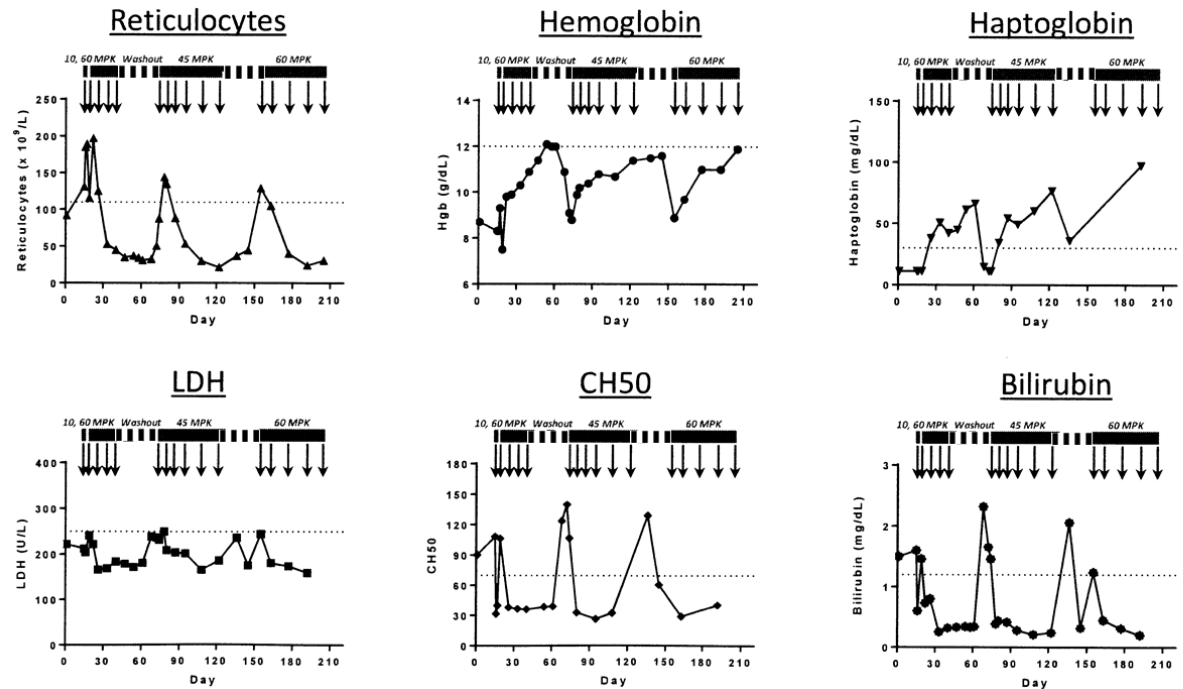
Figure 6. Changes in hemoglobin levels, markers of hemolysis, and complement activation assay (CH50) in a representative patient with CAD treated with sutimlimab in a phase 1b trial. All variables normalized rapidly during treatment periods and resumed abnormal levels at the end of 30 days washout, but normalized rapidly again on re-treatment. Continuous horizontal bars, treatment periods; arrows, administration of sutimlimab; hatched horizontal bars, washout periods. LDH, lactate dehydrogenase; MPK, mg per kg body weight. Reproduced from Jäger, D’Sa, Schörgenhofer et al. Blood 2019 (Supplemental data) [122] under general permission. © the American Society of Hematology.